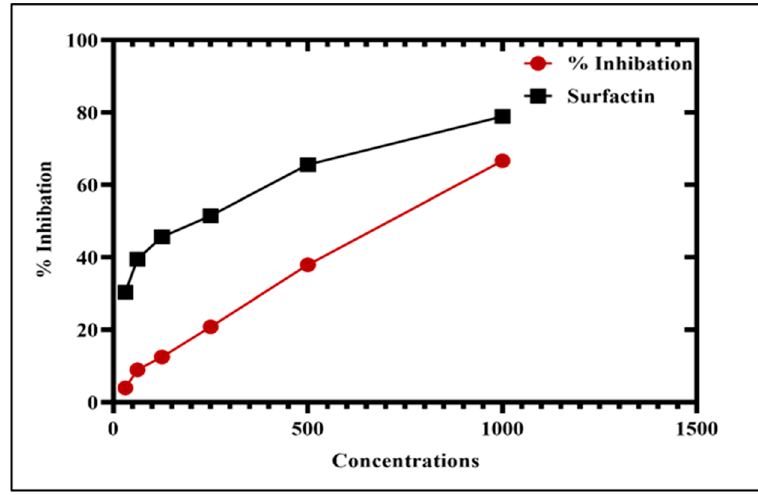
Figure 9. Antidiabetic potential of Ag 2 ONPs against alpha-amylase.